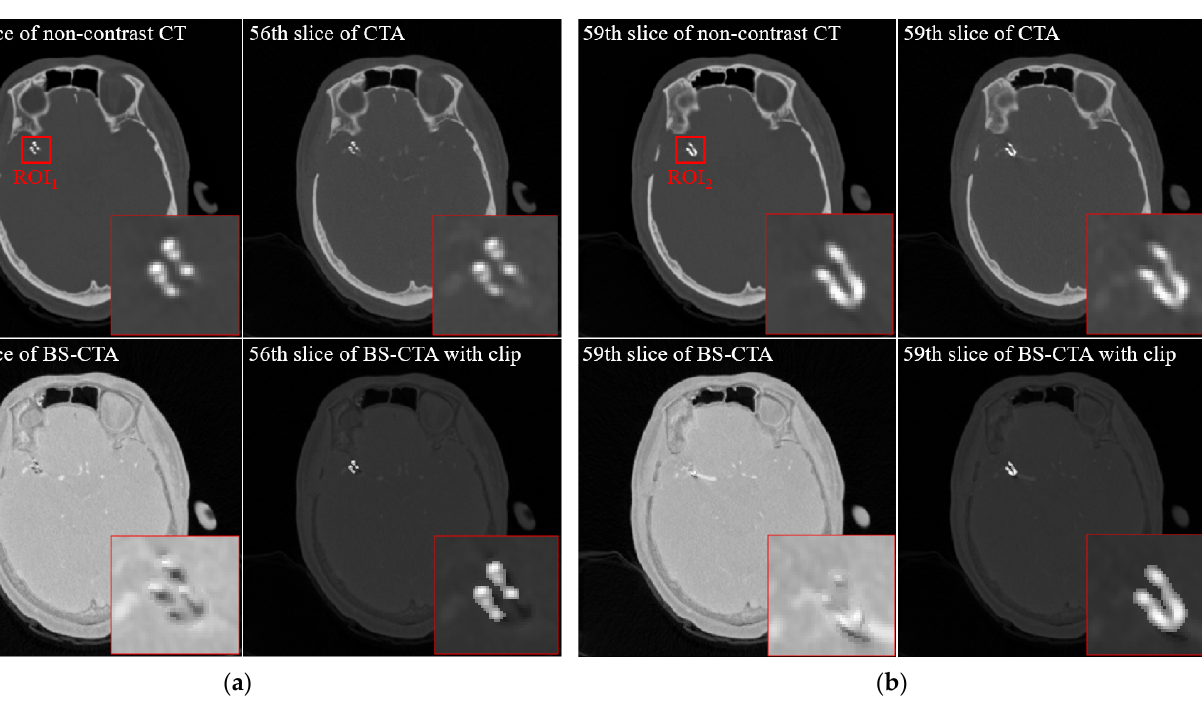
Figure 4. Examples of the non ‐ contrast CT ( left upper ), the CTA ( right upper ), the BS ‐ CTA ( left bottom ) , and the proposed BS ‐ CTA ( right bottom ); ( a ) 56th slice and ( b ) 59th slice. Table 2. Dice similarity coefficient (DSC) and Hausdorff distance (HD) descriptive statistics are shown in Figure